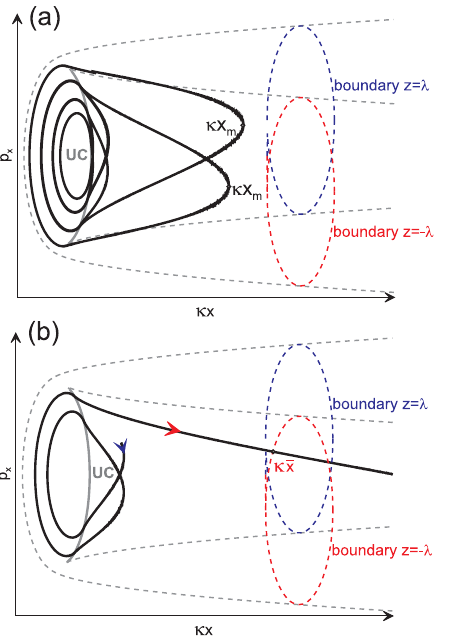
Fig. 8. Trajectories of two particles in the system with κ = 0 .